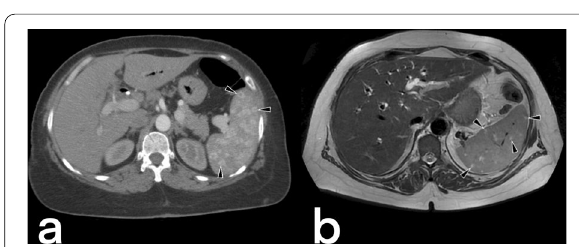
Fig. 28 Axial contrast-enhanced CT ( a ) and axial T2 weighted MR ( b ) images of a 66-year-old female demonstrate multiple foci (arrowheads) in the spleen. Note small hypodense areas with peripheral enhancement in foci ( a ). Splenic TB